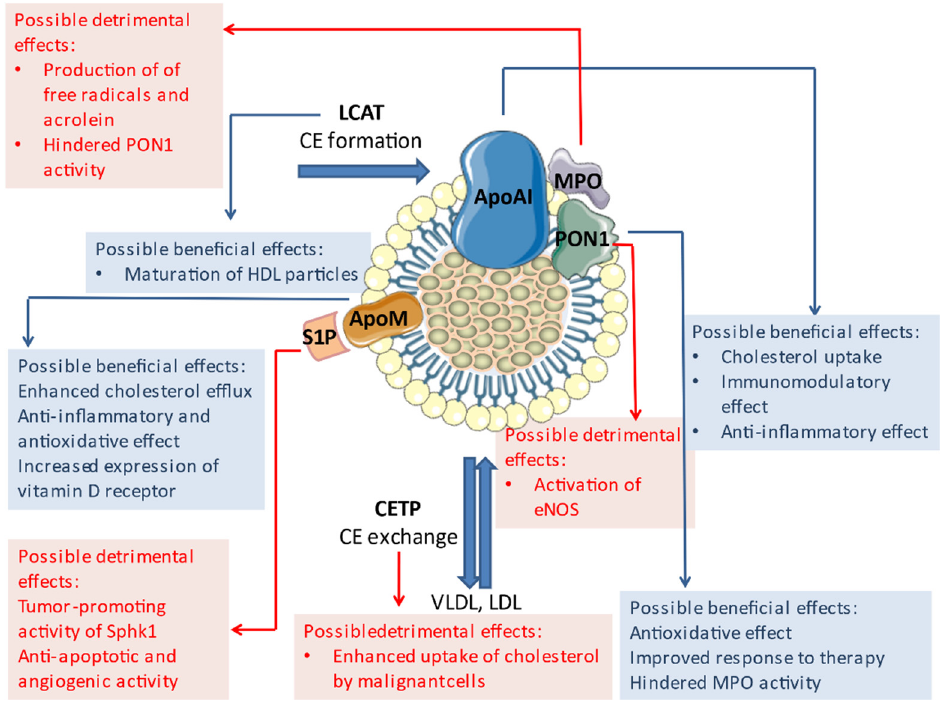
Figure 2. Constituents of HDL functionality and their presumed role in CRC development. ApoAI—apolipoprotein AI; apoM—apolipoprotein M; CE—cholesterol esters; CETP—cholesteryl ester transfer protein; eNOS—endothelial nitric oxide synthase; LCAT—lecithin:cholesterol acyltransferase; LDL—low-density lipoprotein; MPO—myeloperoxidase; PON1—paraoxonase 1; Sphk1—sphingosine kinase 1; VLDL—very low density lipoprotein. The figure was composed using